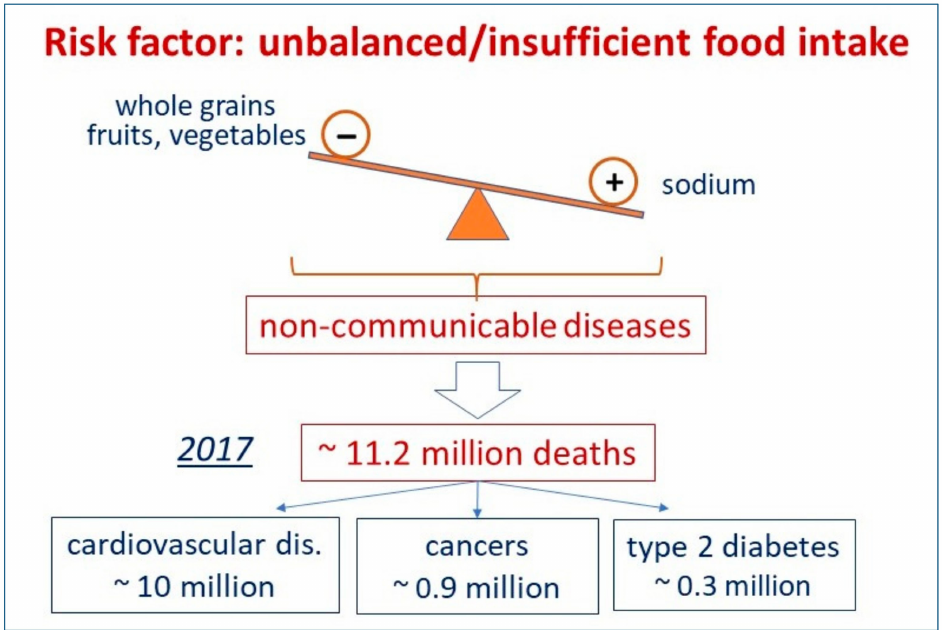
Figure 1. Unbalanced dietary factors, incidence/type of non-communicable diseases and deaths in 195 countries, in 2017